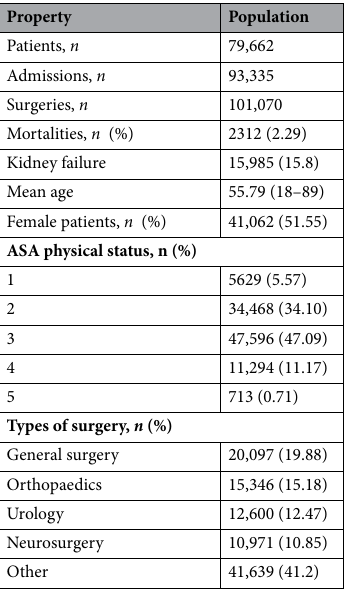
Mortality AKI ROC-AUC